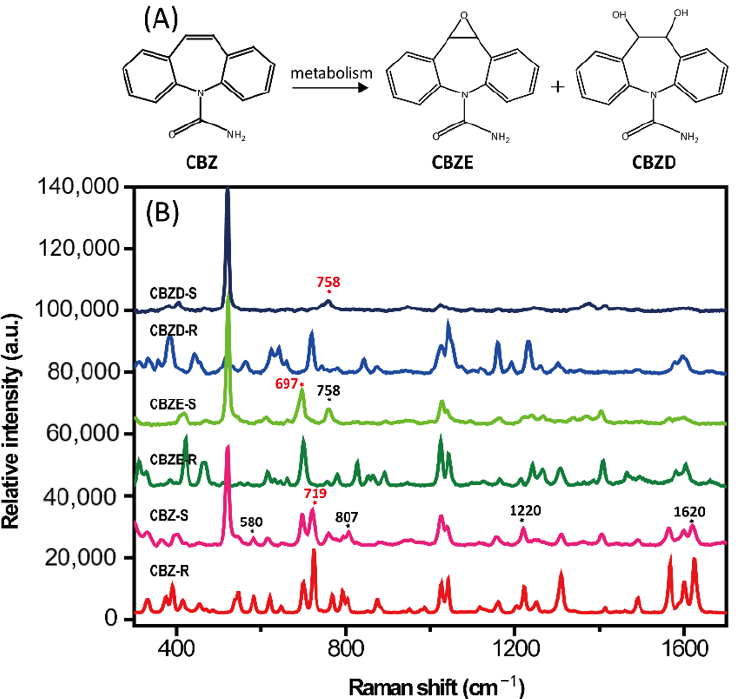
Figure 4. ( A ) The chemical structure of carbamazepine (CBZ), carbamazepine-10,11-epoxide (CBZE), and carbamazepine-10,11-dihydroxide (CBZD). ( B ) Surface-enhanced Raman spectroscopy (SERS) spectra (-S) and normal Raman spectra (-R) of CBZ, CBZE, and CBZD.